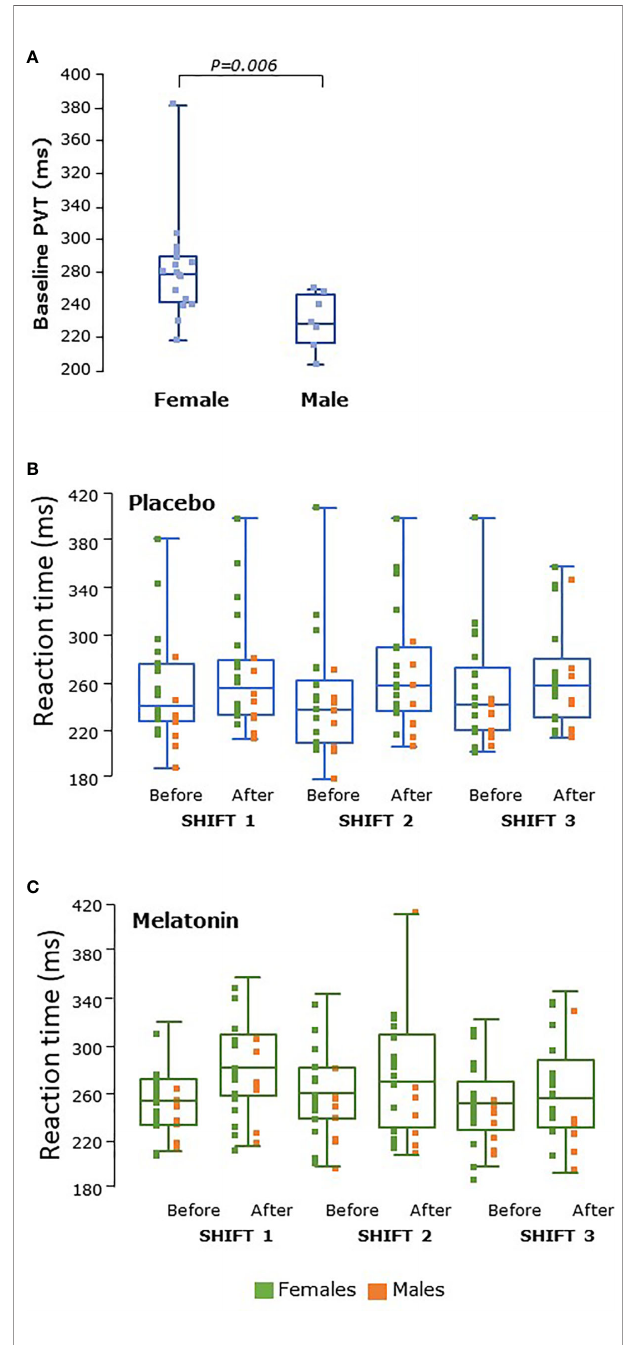
FIGURE 6 | (A) Psychomotor vigilance testing (PVT) as reaction time in male (n = 8) and female (n = 17) participants at baseline, before the fi rst shift regardless of treatment arm. Reaction times were signi fi cantly faster in males than females at baseline (P = 0.006). (B) PVT tests before and after placebo shifts and (C) PVT before and after melatonin shifts. Female participants ’ data points are shown in green and male participants ’ in orange. Reaction times were faster in males than females during all shifts. Reaction times were signi fi cantly higher after shifts (P = 0.0007) in both males and females than before. Box and whisker plots show median, interquartile, and full range with individual raw data points